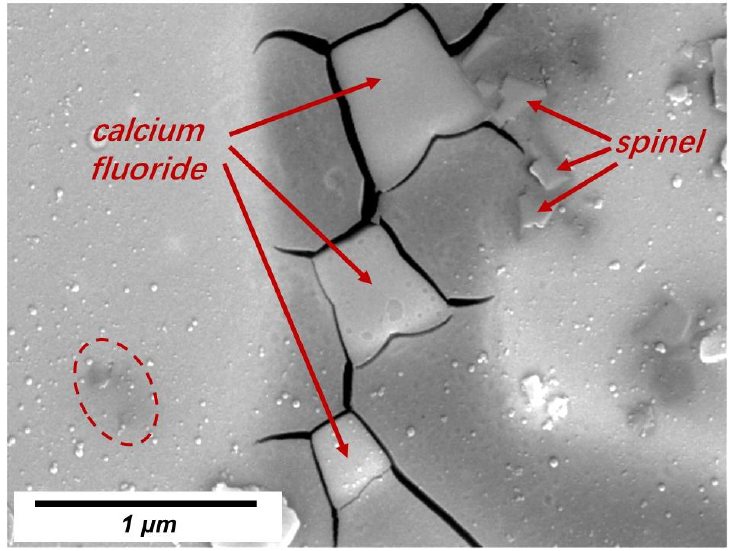
Figure 5. Backscattered SEM image of typical morphology of the devitrified crystals in the No. 3 slag film solidified in molten slag at 1300 °C.